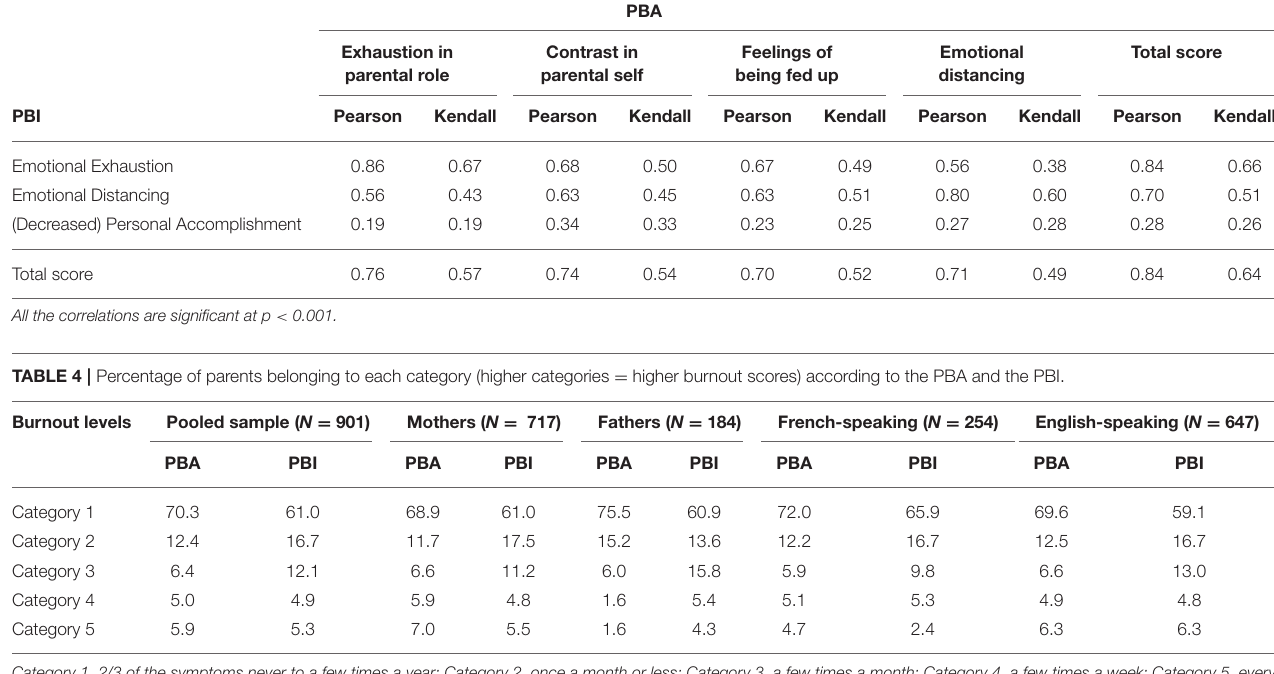
TABLE 3 | Pearson and Kendall correlations between PBA and PBI (factors and global scores). PBI Pearson Kendall Pearson Kendall Pearson Kendall Pearson Kendall Pearson Kendall